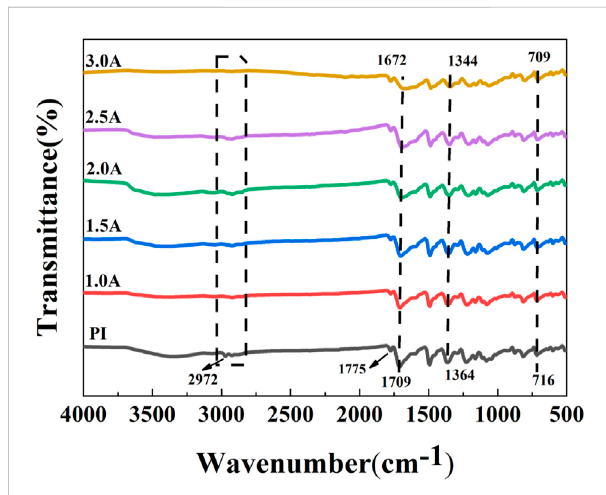
FIGURE 4 Fourier infrared spectroscopy of PI surface treated by carbon plasma with different graphite target currents.